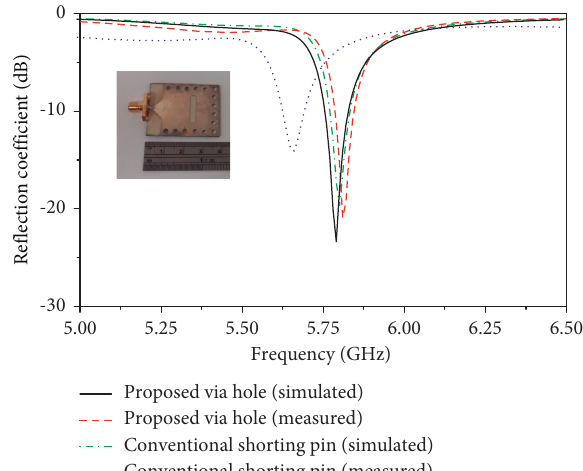
Figure 11: Reflection coefficient of the SIW cavity slot antennas fabricated using the proposed fully inkjet-printed via hole and the shorting